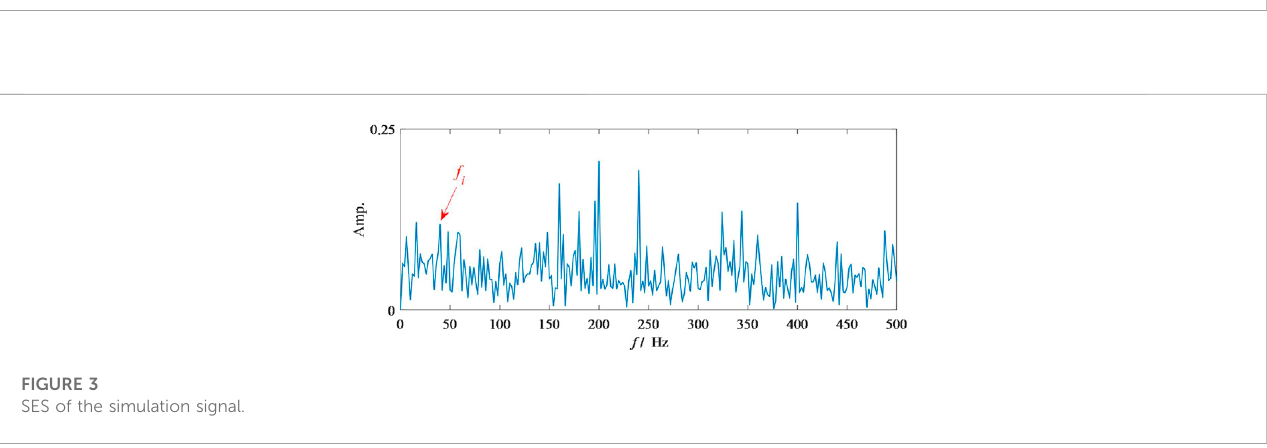
FIGURE 2 Simulation signal: (A) harmonic component y 1 , (B) periodic impulse component y 2 , (C) interface impulse component y 3 , and (D) composite signal y .